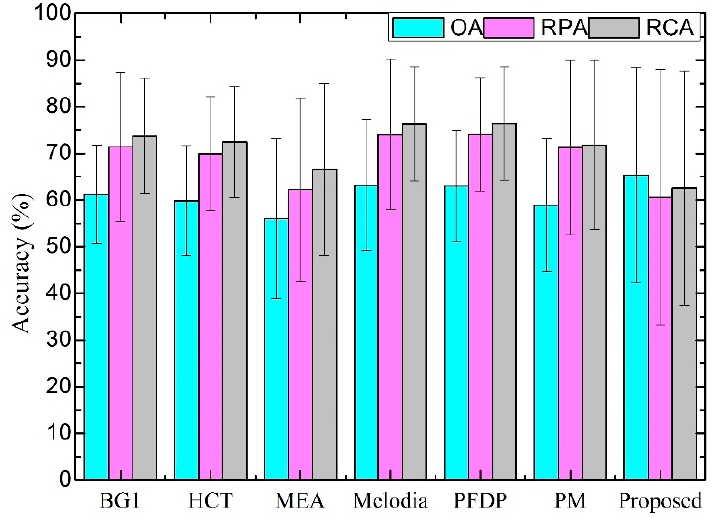
Figure 5. Accuracies on ISMIR2004.